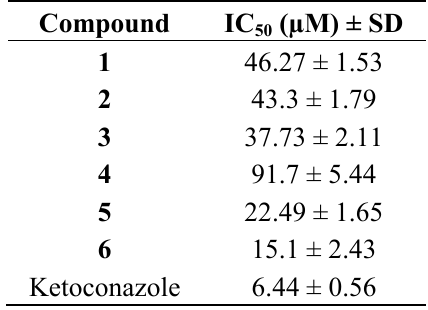
Table 4. Inhibitory activity on CYP3A4 enzyme of compounds 1 – 6